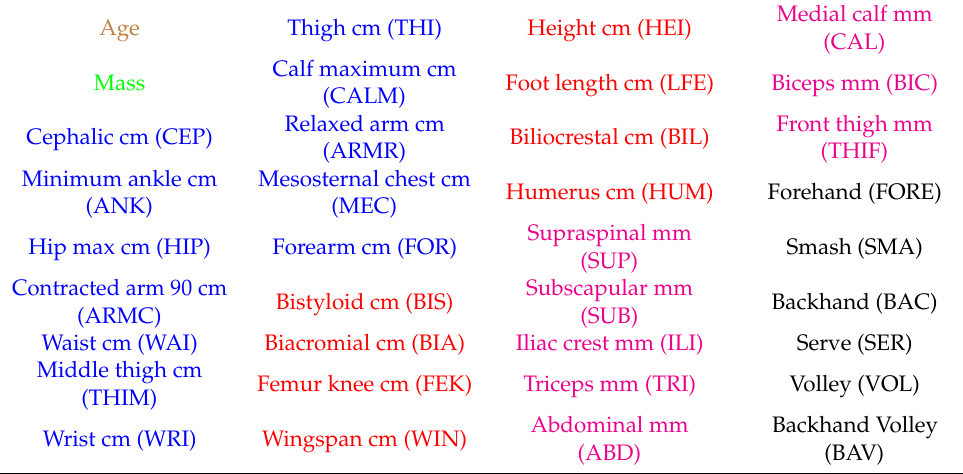
Table 1. Tennis dataset’s anthropomorphic measurements. The color represents the measurement group: age (brown), weight (light green), length (red), perimeters (blue), fat fold (pink), and tennis move